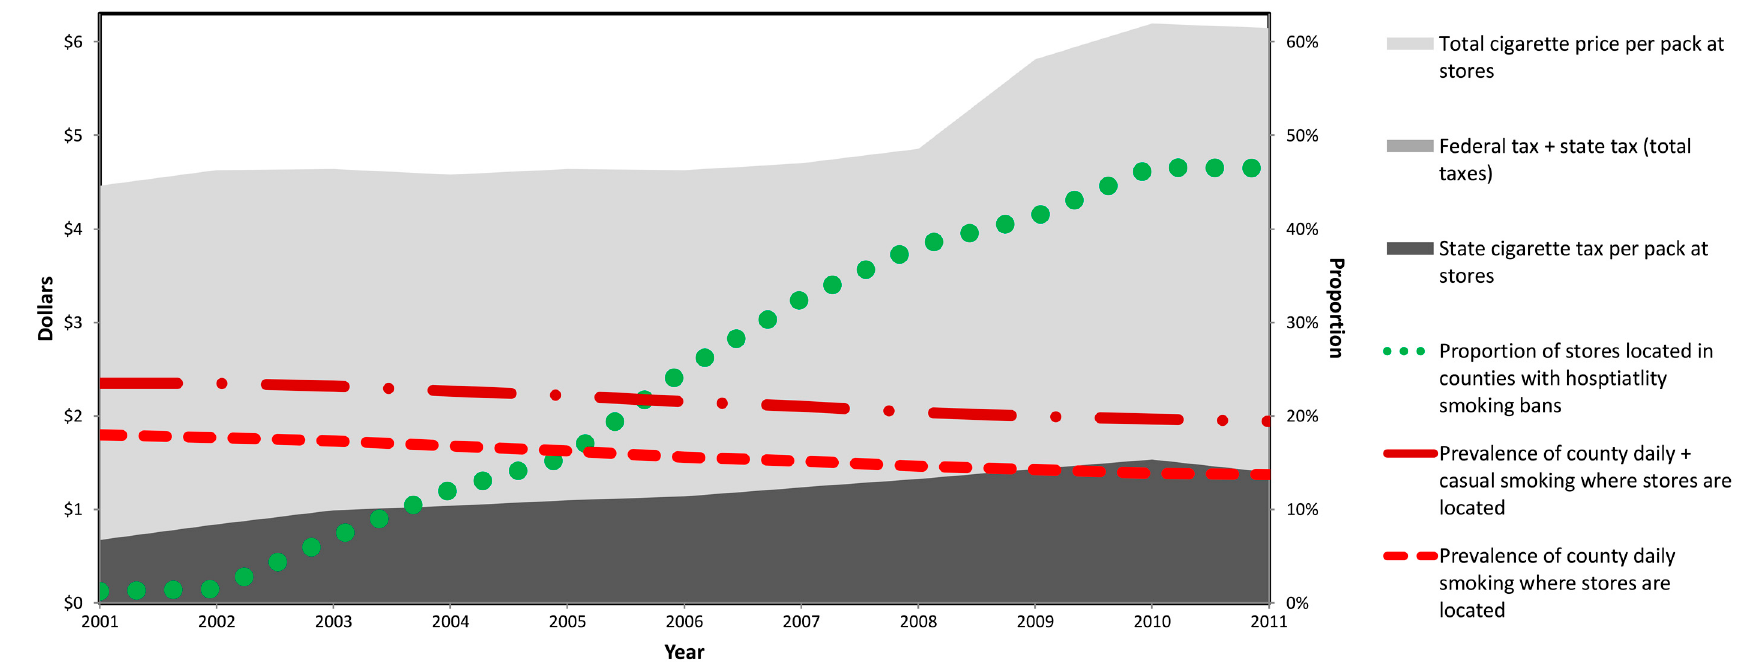
Figure 1. Per pack cigarette price and taxes at chain supermarkets and drug stores, county hospitality indoor smoking bans, and county smoking prevalence, 2001–2011. All prices and taxes were adjusted to 2010 dollars.